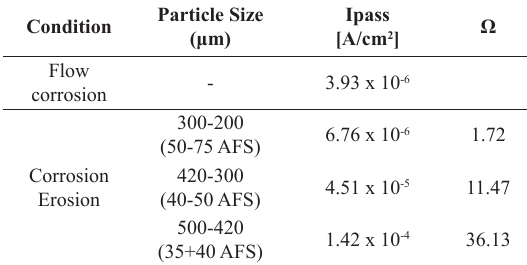
Table 3. Ω parameter to quantify the effect of erosion on corrosion